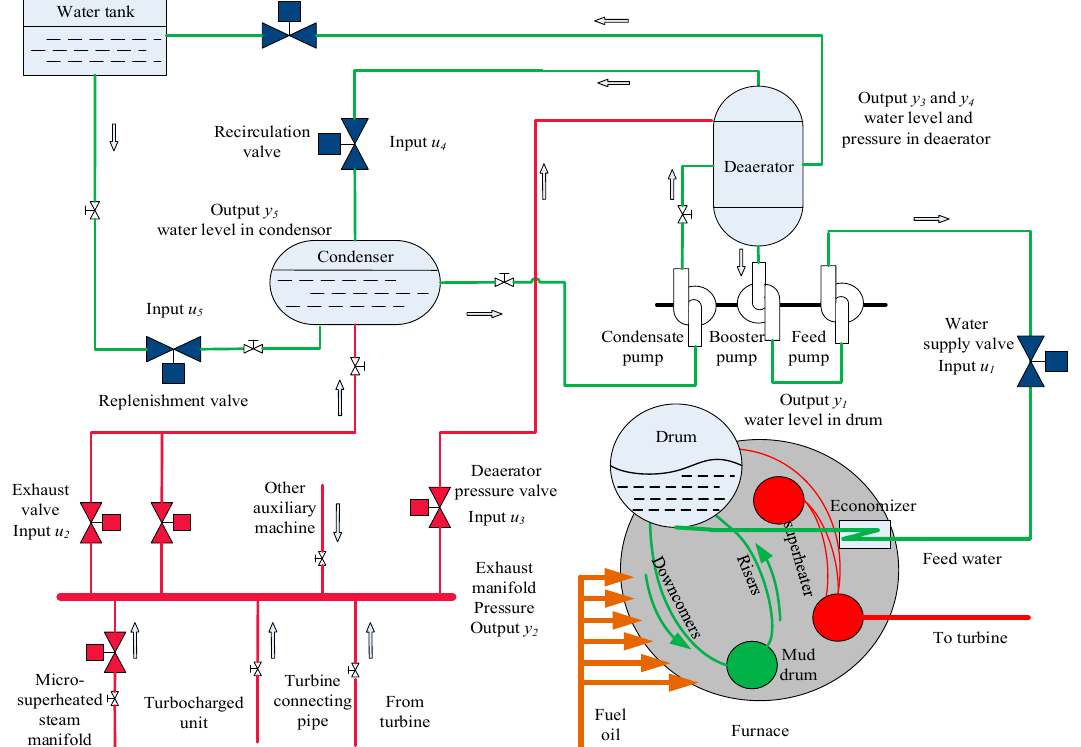
Figure 1. Scheme of a complete steam/water loop [28] (reproduced with permission from Zhao, S.; Maxim, A.; Liu, S.; De Keyser, R.; and Ionescu, C, Processes; published by MDPI, 2018).